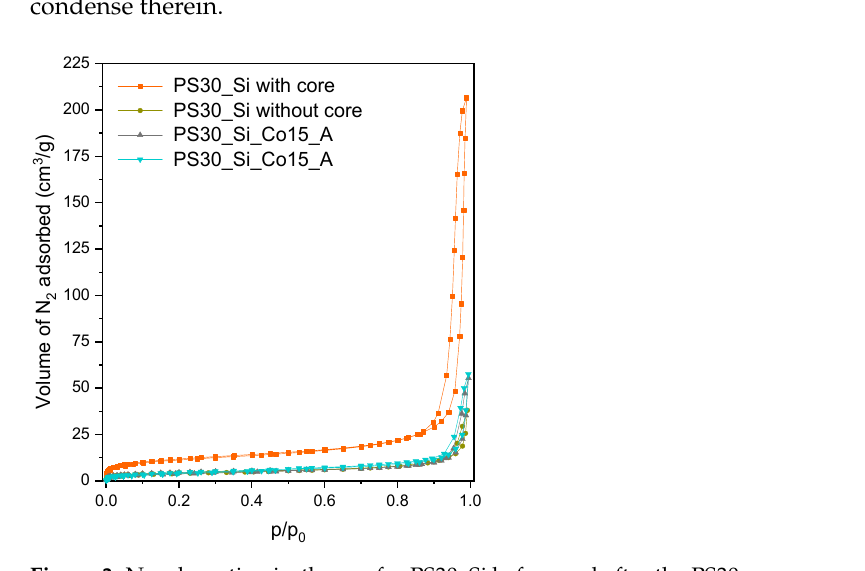
Figure 3. N 2 adsorption isotherms for PS30_Si before and after the PS30 core removal as well as the PS30_Si_Co15 catalysts synthesized in the paths A and B. Table 1. Chemical composition, Co 3 O 4 crystallite size and textural parameters of the studied PS30_Si-based samples.